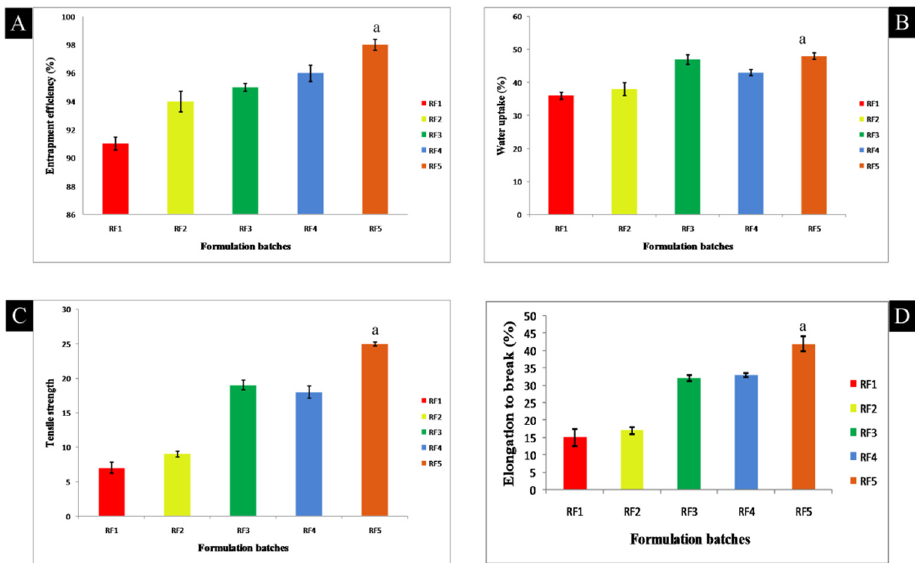
Polymers 2021 , 13 , x FOR PEER REVIEW